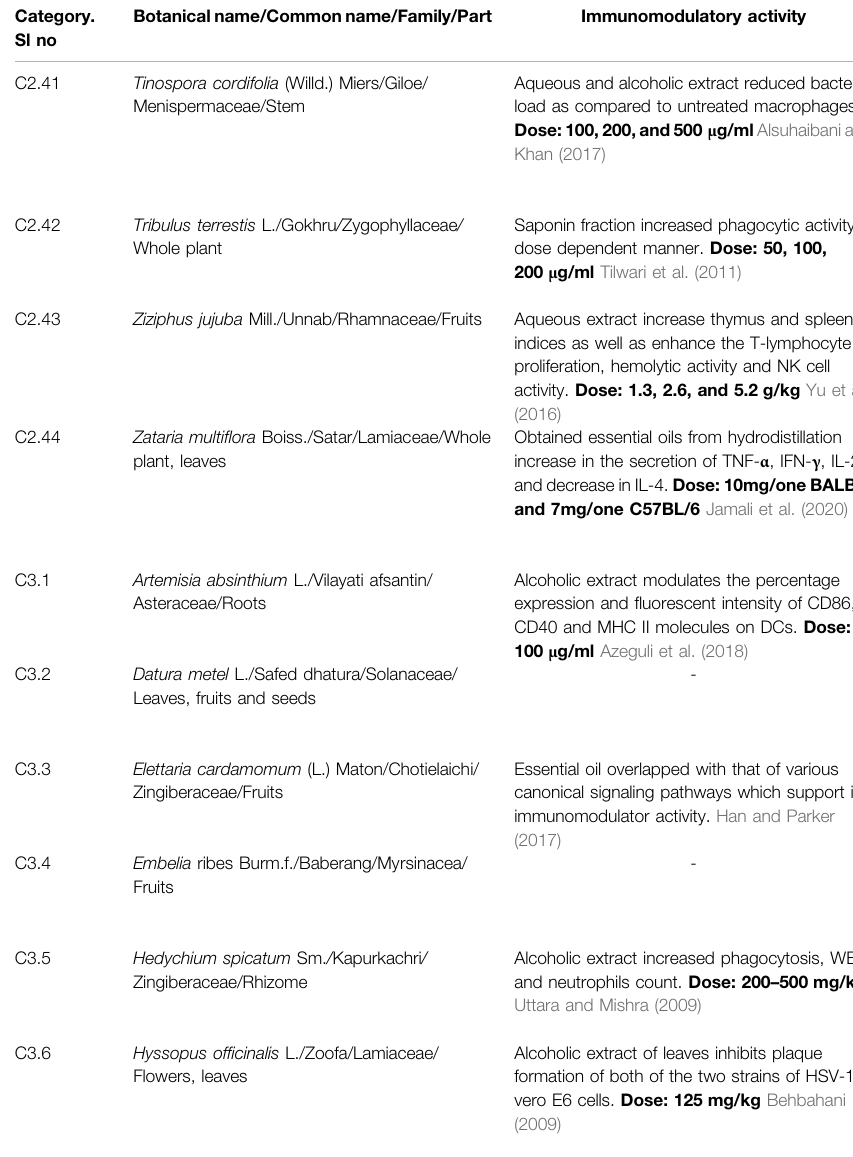
TABLE 5 | ( Continued ) List of Indian Medicinal Plants/AYUSH drugs with proven immunomodulatory, antiviral and anti-allergic/anti-in fl ammatory/anti-asthmatic activity having potential for exploring against COVID 19 categorized for prioritization on the basis of their earlier